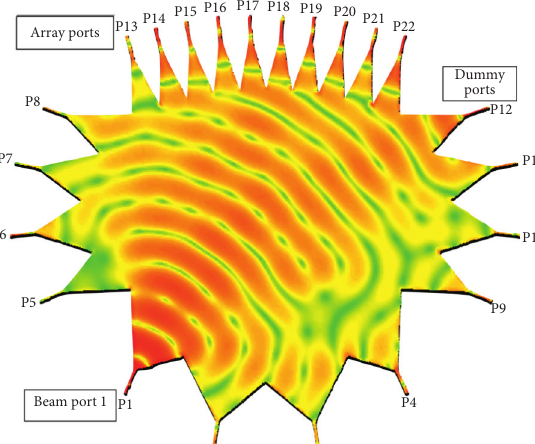
Figure 7: S-band Rotman lens: current distribution with beam port − 2 feeded in the range between 2 . 0GHz and 3 . 0GHz.